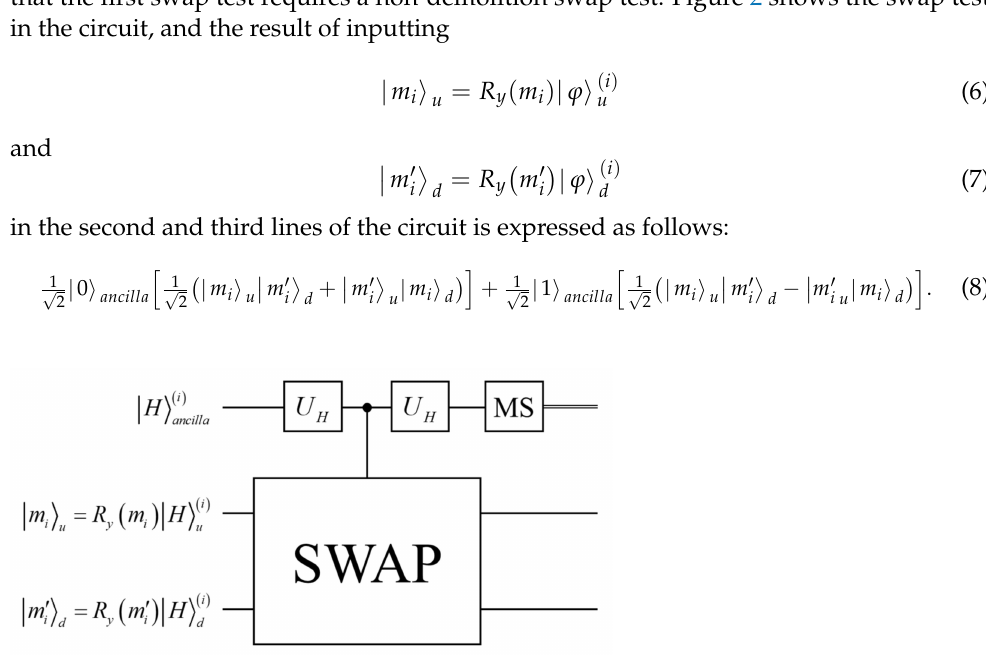
Figure 2. Circuit of the quantum swap test. “SWAP” indicates a swap gate, and U H represents a Hadamard gate. “MS” represents quantum measurement, and the single lines and the double line represent the quantum channel and classical channel,